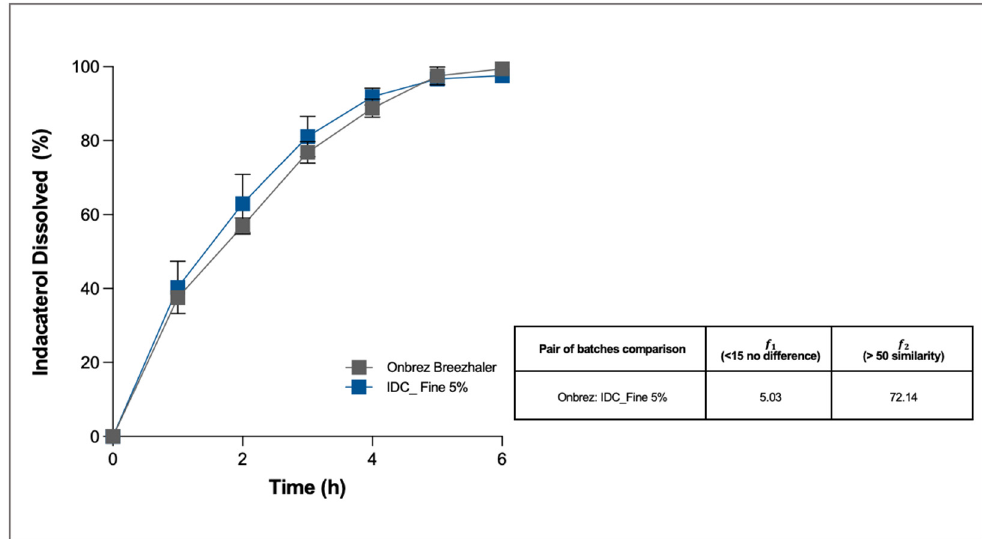
Figure 8. Cumulative mass (%) dissolution profiles of indacaterol test formulation with 5% of fine lactose (IDC_Fine5%) in comparison with the reference product, Onbrez, after aerosolisation ( n = 3, mean ± SD). Difference ( f 1) and similarity factor ( f 2) between the two profiles were calculated.